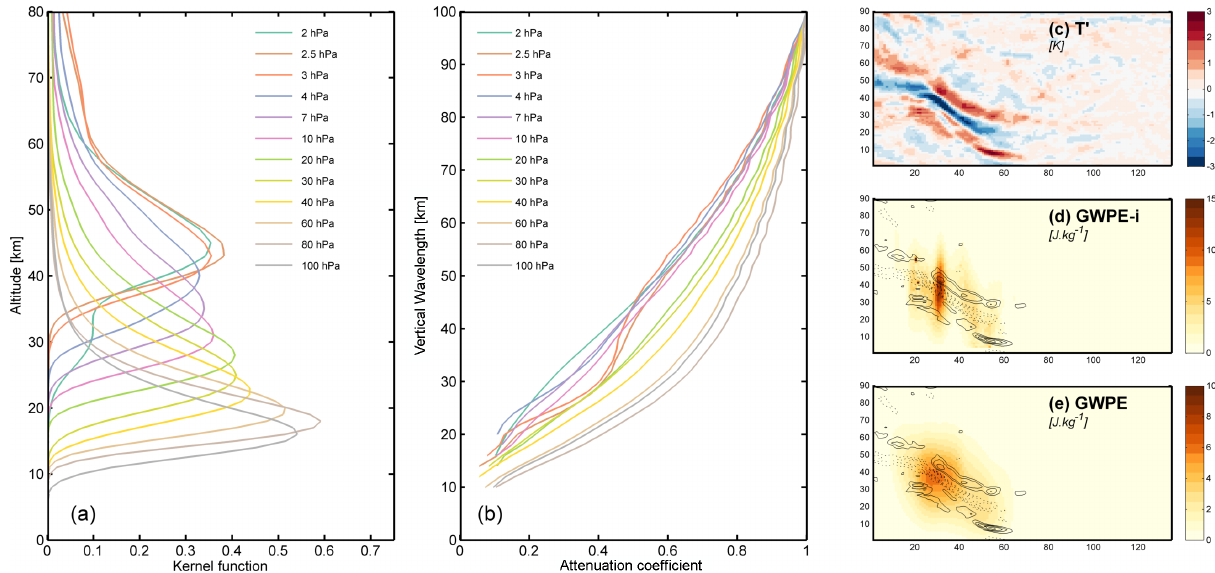
Figure 1. (a) Kernel (“weighting”) functions of the AIRS channels used in our analysis, each plotted against height; (b) attenuation coeffi- cients computed for a theoretical wave of amplitude unity for each channel, plotted against the vertical wavelength of the theoretical wave; (c) temperature perturbation granule observed by AIRS on 6 September 2003; (d) interim GWPE values computed from this measurement granule, with temperature perturbations from panel (c) overplotted for reference; (e) as (d) , but smoothed with a 10-pixel disc smoother to approximate averaging over the full cycle of the